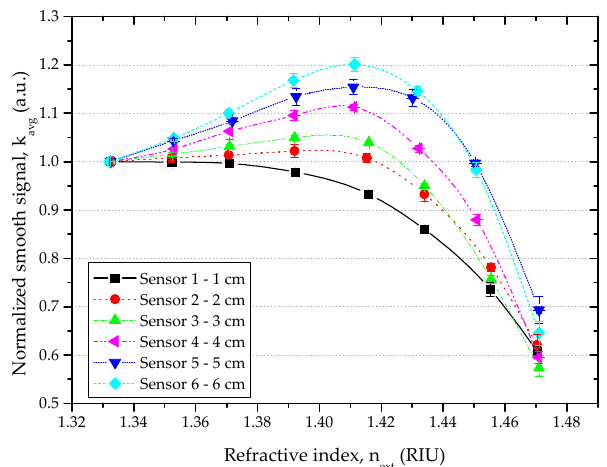
Figure 5. Normalized smooth signal vs. refractive index (RI) for all D-shaped sensors, RI range 1.33–1.47.